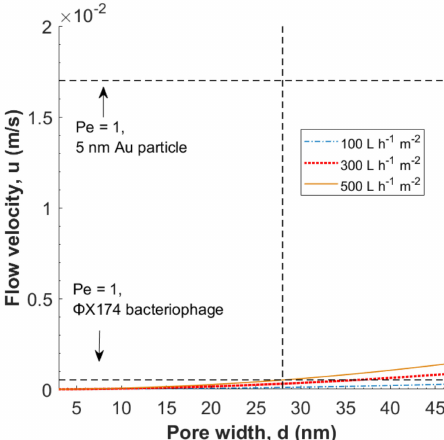
Figure 6. Local flow velocity u in pores of width 3–46 nm and d m = 23 nm, at fluxes 100, 300 and 500 L h − 1 m − 2 . Figure constructed using Equation (3). Horizontal dashed lines indicate Pe = 1, i.e., u = u cr , for 5 nm gold particles and Φ X174 bacteriophages respectively. The vertical dashed line at d = 28 nm highlights a pore width equal to the diameter of the Φ X174